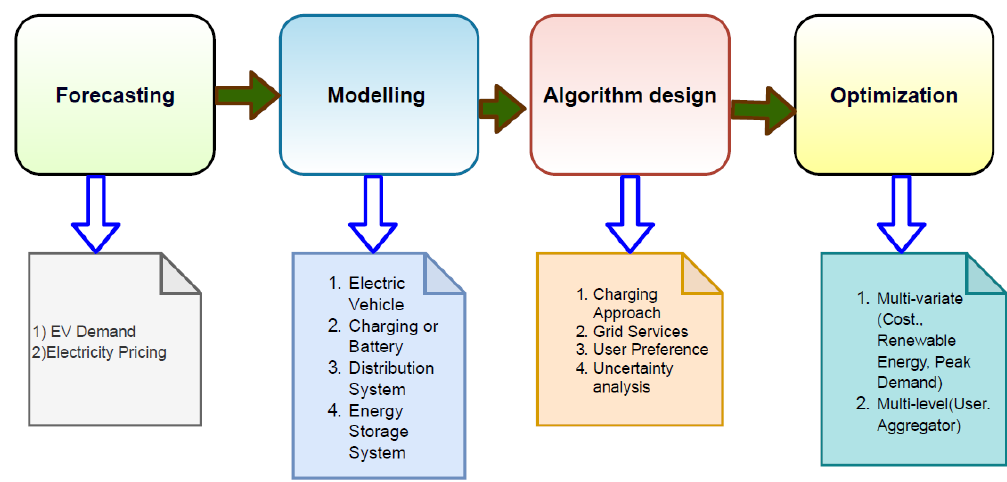
Figure 7. A general outline for modelling a grid-connected EV charging schedule.